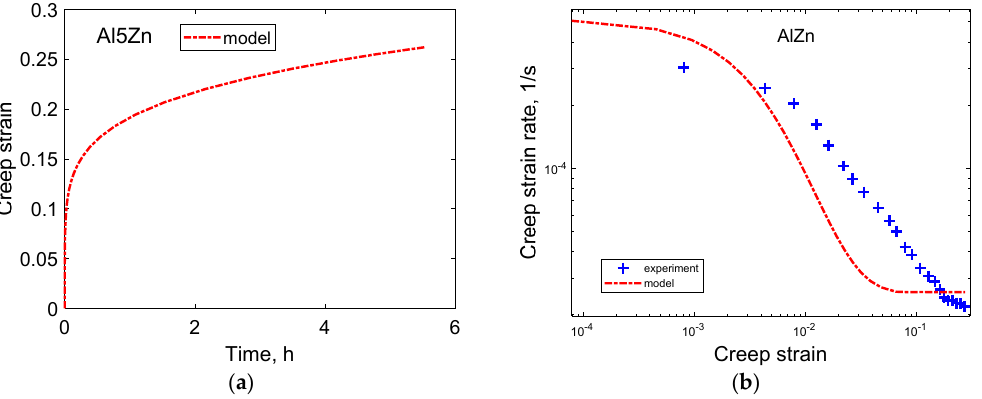
Figure 2. Creep strain versus time ( a ) and creep rate versus strain ( b ) for Al5Zn at 250 °C and 16 MPa. Experimental data from [2,29].